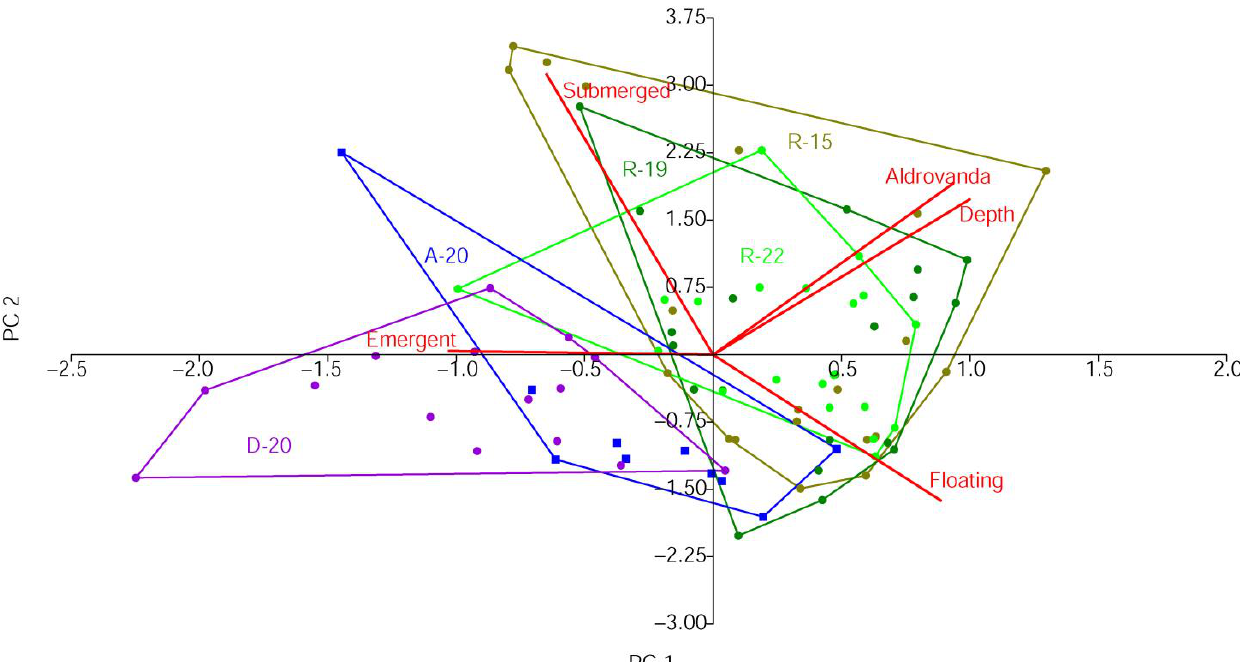
Figure 5. Principal component analysis of studied Aldrovanda vesiculosa populations based on density of individuals; cover of submerged, floating-leaved (excluding Aldrovanda vesiculosa ), and emergent plants; and water depth in sampling plots. Different-coloured symbols and convex hulls indicate different study years and lakes: Lake Rūžas (olive , green, and light green in 2015 (R-15), 2019 (R-19), and 2022 (R-22), respectively), Lake Apvardai (blue in 2020 (A-20)), and Lake Dysnai (dark purple in 2020 (D-20)).